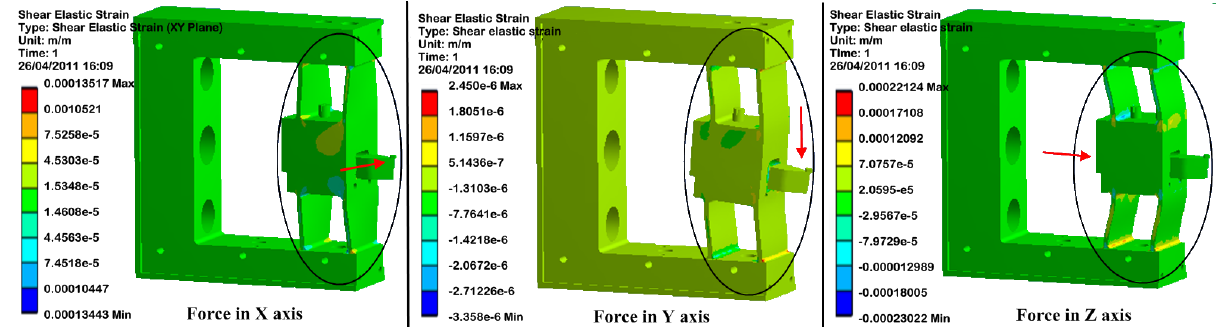
Figure 8: The shear stain and stress area in X, Y and Z direction applied force The displacement in Z direction when force is applied from 0 to 200 N, increased by 10 N, is analyzed. The relationship between the displacement and the force in the Z direction shows in Figure 8. The shear stain and stress area in X-, Y- and Z-direction applied force. Figure 9. It can be observed that the relationship between them is in the linear manner. The gradient of the line; the axial stiffness of the CM in the axial direction is 11.979 N/µm; the correlation coefficient is 1.0; the Y-intercept is -0.0248 N. y = 11.979x -0.0248 R² = 1